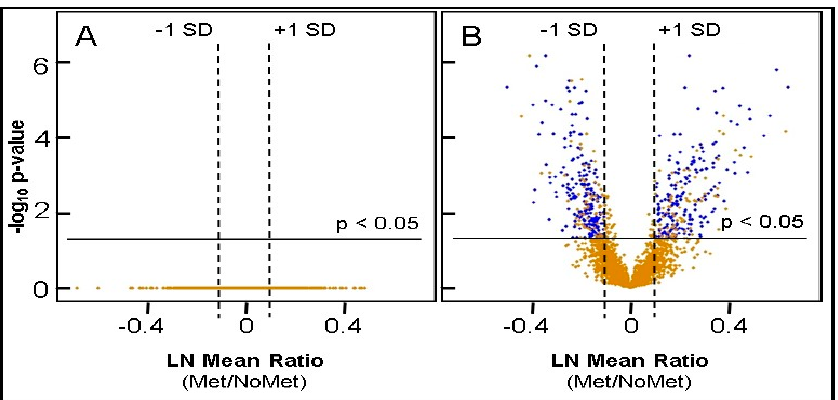
Figure 1. Volcano Plots. ( A ) Volcano plot for 2504 proteins from choroid specimens excised from 6 metastasizing and 7 non-metastasizing UM eyes ( B ) Volcano plot for 3935 proteins from 53 metastasizing pUM and 47 non-metastasizing pUM. Blue represents DE (differentially expressed) proteins and gold represents all other proteins not satisfying DE criteria. No significantly altered proteins were found in the choroid controls from UM eyes; 402 DE proteins were identified in the pUM.